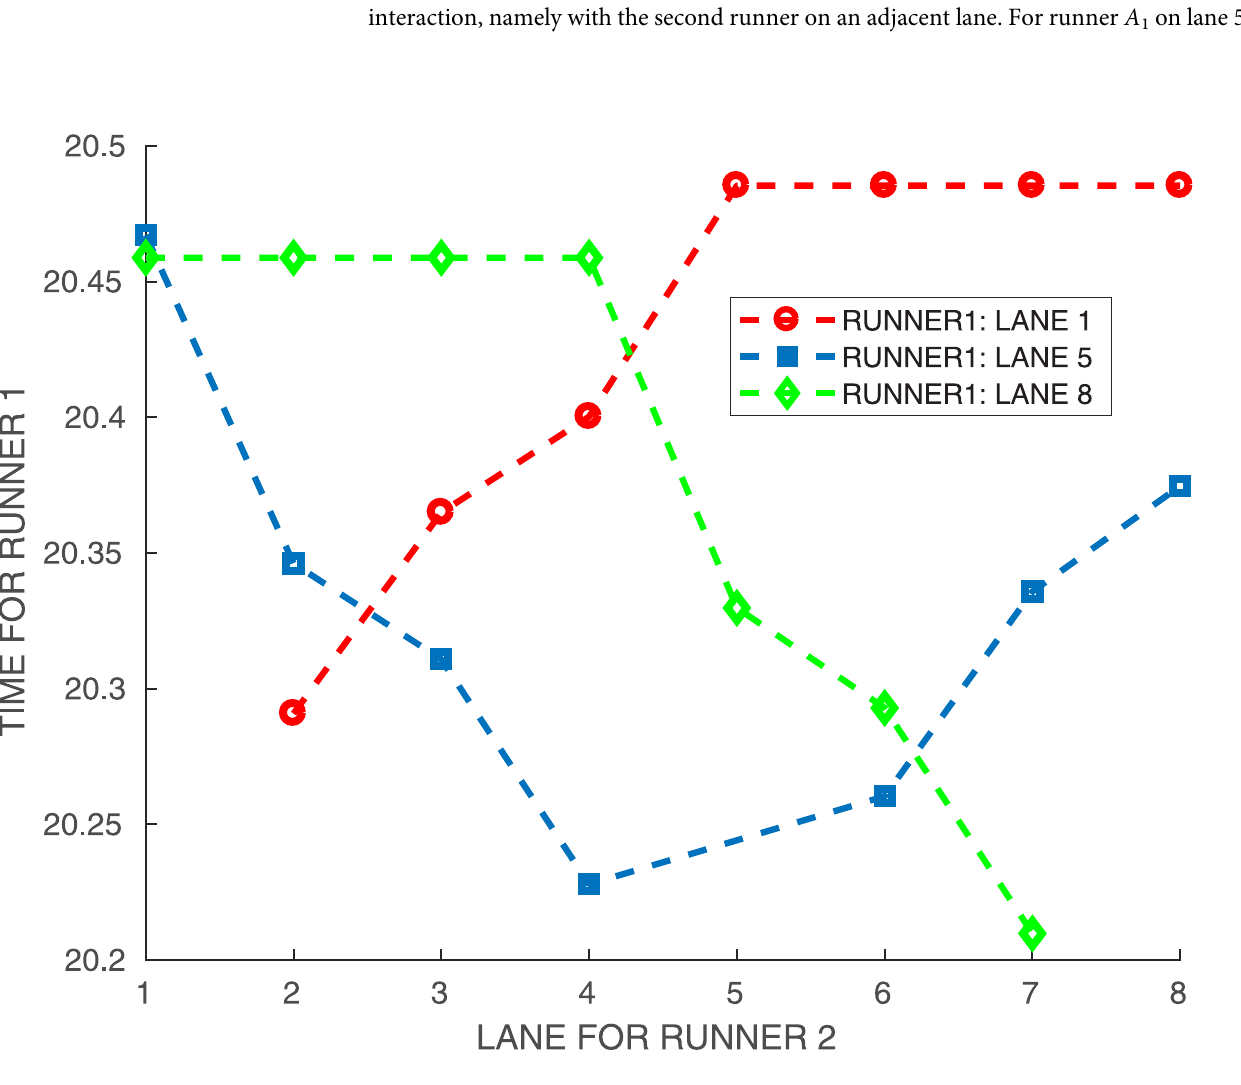
Fig 10. Times for athlete A 1 at lanes 1,5,8, running against